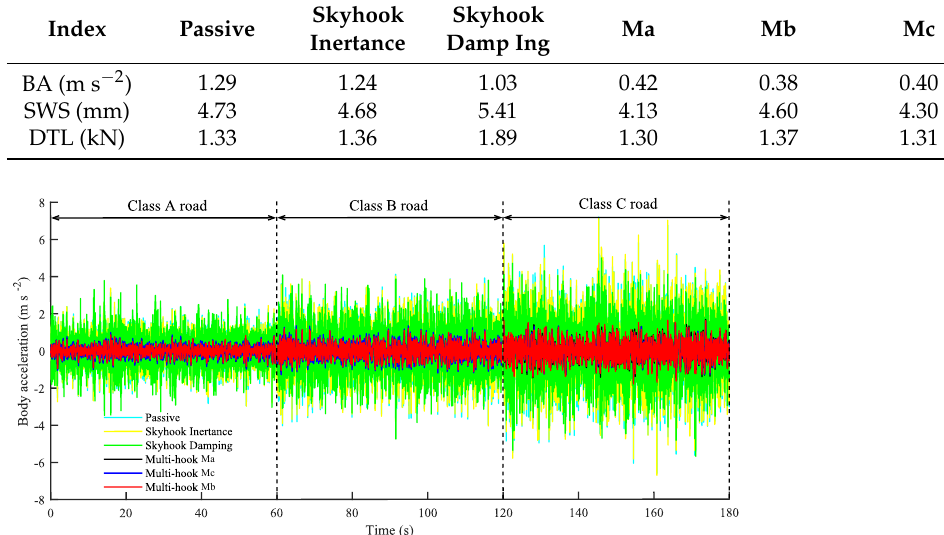
Figure 7. Time response comparison of body acceleration for single-skyhook and multi-hook control strategies.